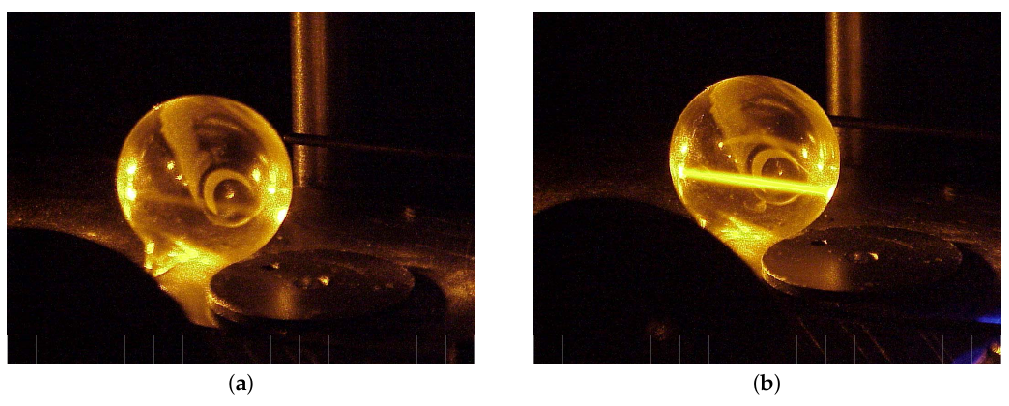
Figure 1. Sodium fluorescence at room temperature without ( a ) and with ( b ) atom ejection induced by 435 nm LED radiation. The photos are related to the experiment presented in